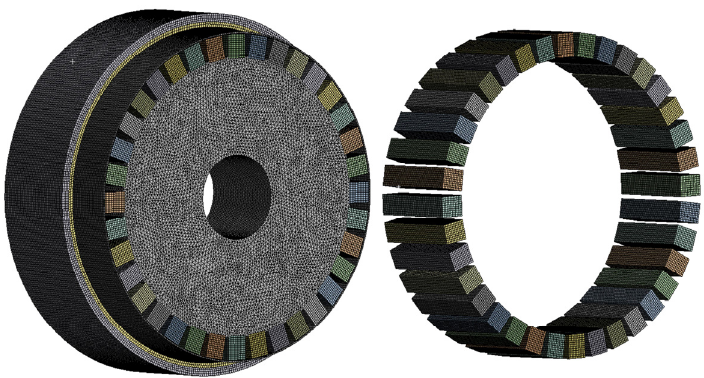
Figure 6. Meshing of CPMG.